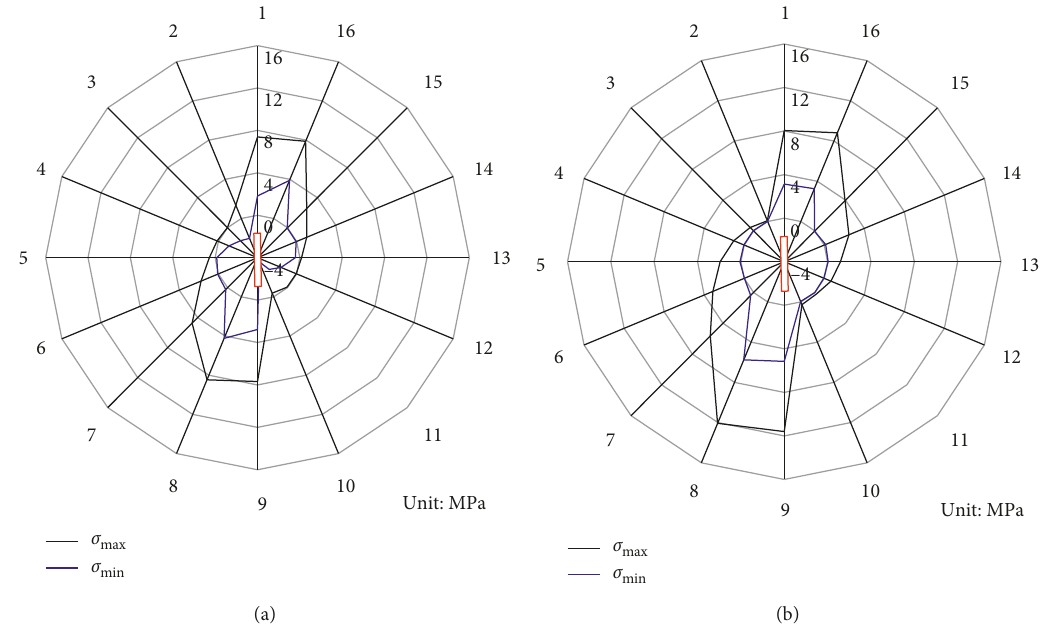
Figure 22: Principal stresses around middle joint for B90 at (a) crack initiation stress and (b) peak shear